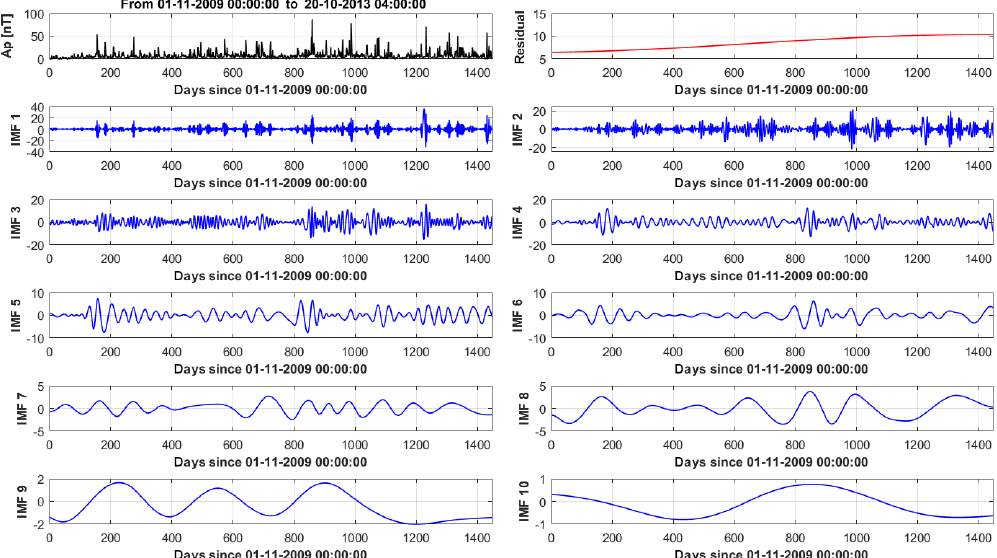
Figure 7. EMD decomposition for the geomagnetic index Ap. Top row: original signal and trend. From first row: successive orders of basis functions